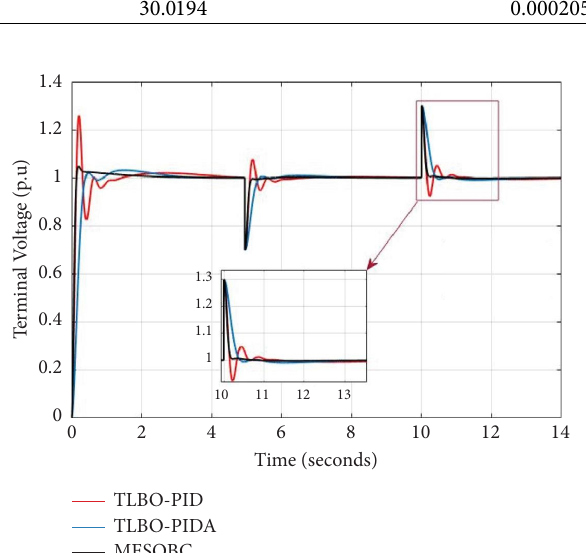
Figure 6: Response of terminal voltage under +50% parametric uncertainties ( T